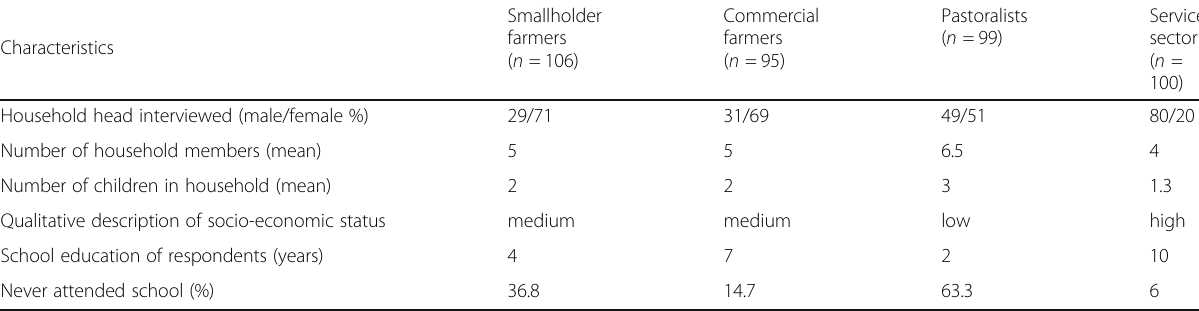
Table 3 Characterisation of different user groups in Ewaso Narok